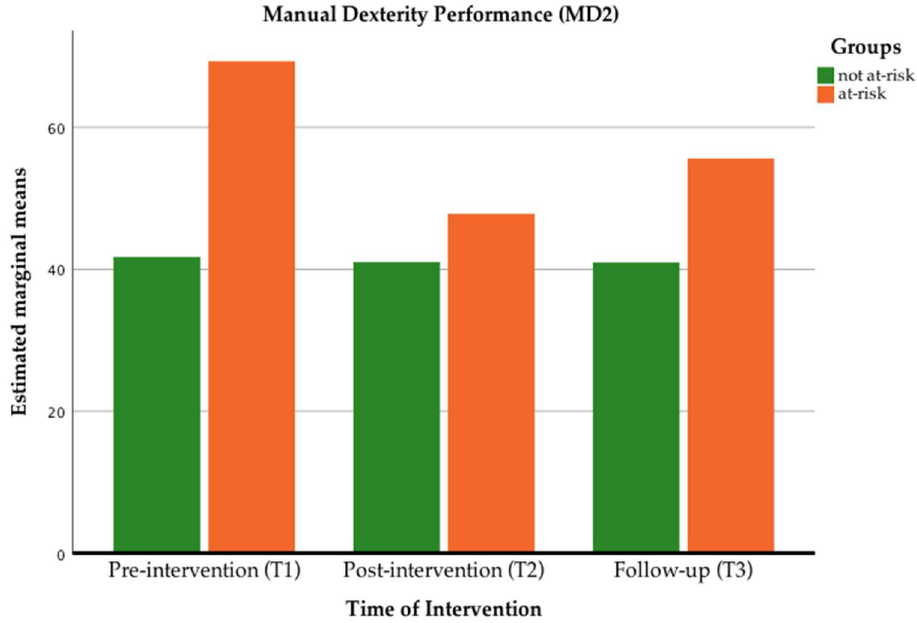
Figure 1. Changes on manual dexterity scores in at-risk and not at-risk children over time.